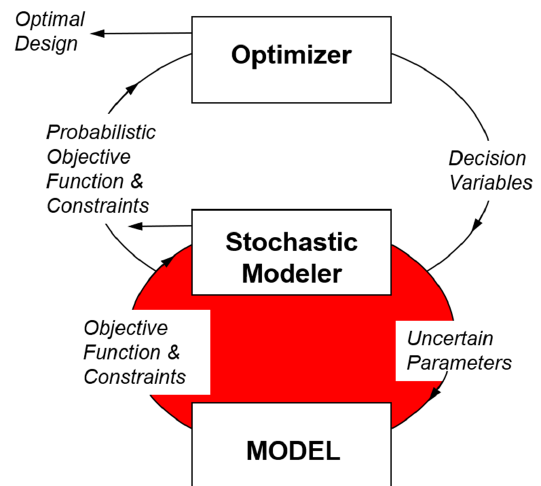
Figure 1. Pictorial representation of a stochastic optimization problem (Reproduced from Diwekar and David, 2015). 287